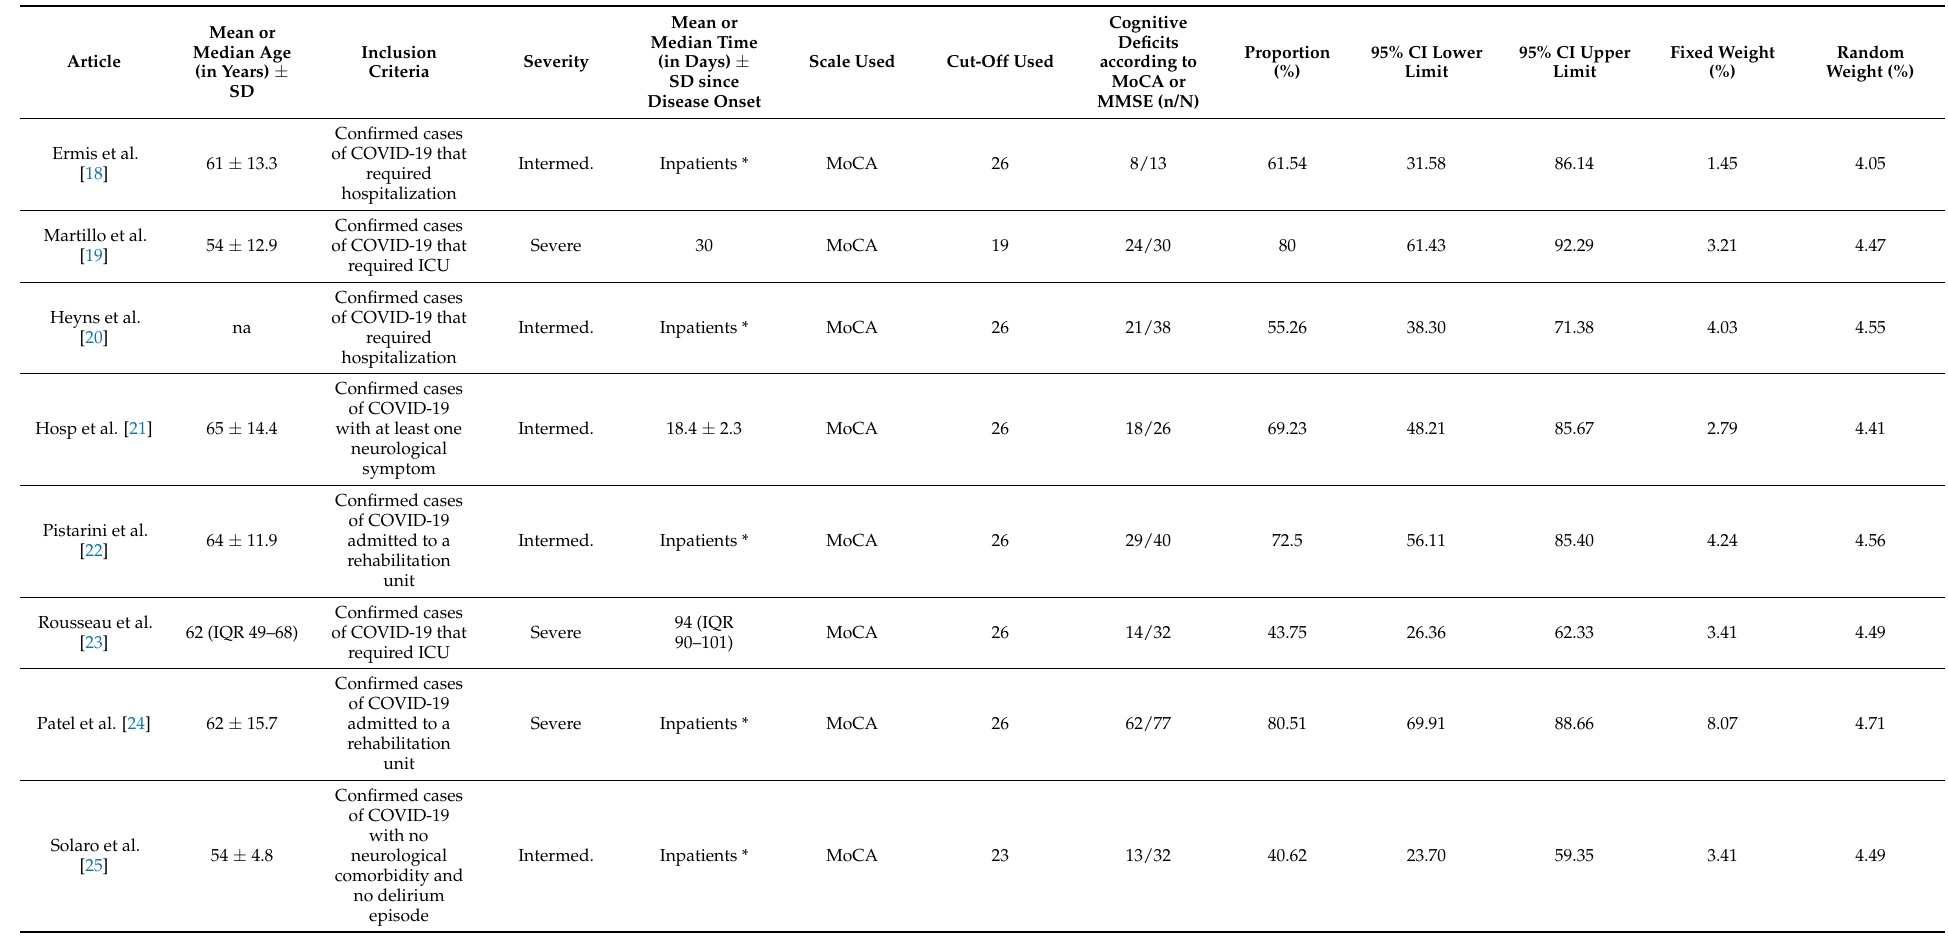
Table 1. Single group summary for